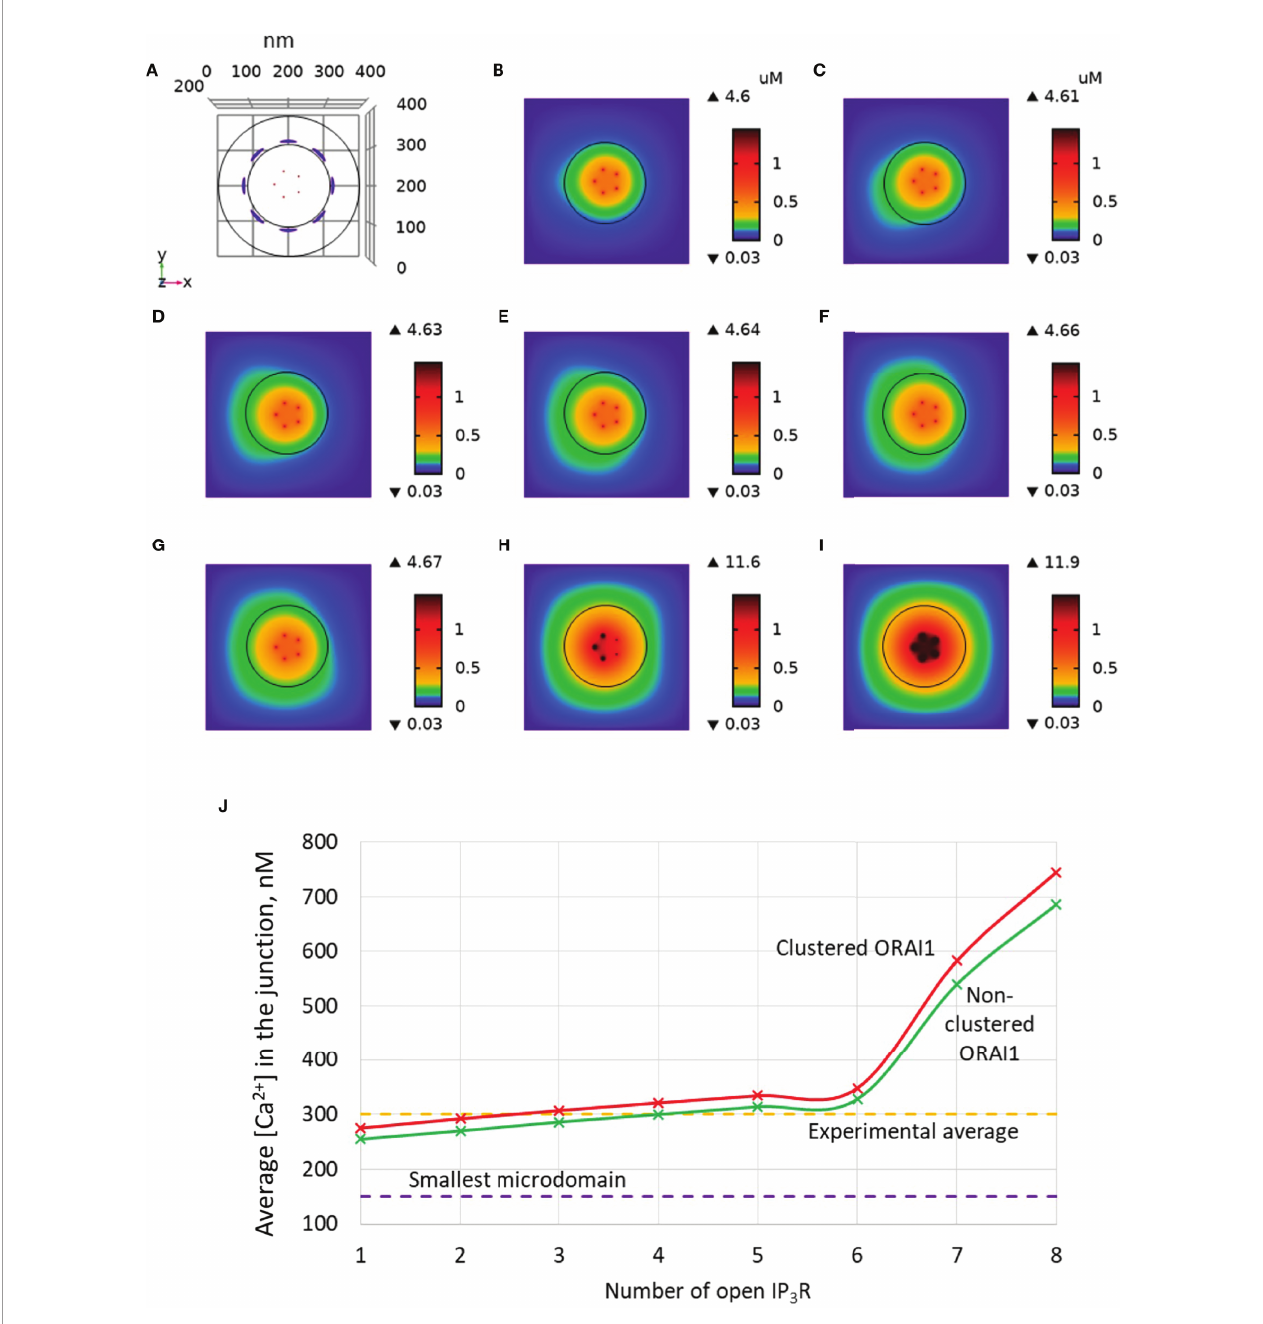
FIGURE 8 | In fl uence of the distance between ORAI1 channels on the Ca 2+ microdomains in the ER-PM junction. The situation is similar to the default situation shown in Figure 3 , except for the distance between ORAI1 channels that is here equal to 37.7 nm (clustered) instead of 47 nm (non-clustered). (A) Upper view of the arrangement of the ORAI1 channels on the PM of the junction (red dots) and of the adjacent IP 3 Rs (blue lines) using COMSOL. (B – I) Steady-state Ca 2+ pro fi les in the junction when opening 1 (B) to 8 (I) IP 3 Rs simultaneously. Left bars indicate the color codes, together with the minimal and maximal concentrations reached in the related panel. Shown are the pro fi les 22ms after opening of the IP 3 Rs. Upon depletion of local Ca 2+ in the ER, which is quasi-instantaneous, ORAI1 channels open to an extent that depends on this local concentration, as de fi ned by the function f (see Supplementary Information ). ORAI1 opening is assumed to occur immediately after depletion because ORAI1-STIM2 aggregates are pre-formed (4). (J) Evolution of the amplitude of the simulated Ca 2+ microdomains with the number of simultaneously open IP 3 Rs in the junction. Results obtained with the default value of the inter-ORAI1 channels distance (47 nm, non-clustered) corresponding to the results shown in Figure 3 are also indicated for